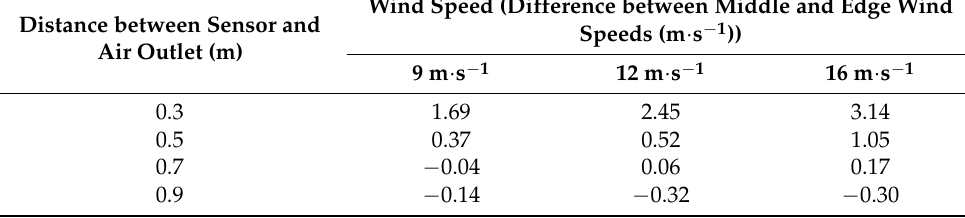
Table 3. Difference between the middle and the edge wind fields at different